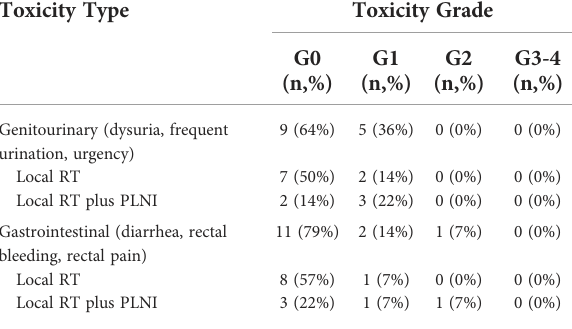
TABLE 4 Acute gastrointestinal and genitourinary toxicity rates scored by clinicians according to the CTCAE scale v5.0. Toxicity Type